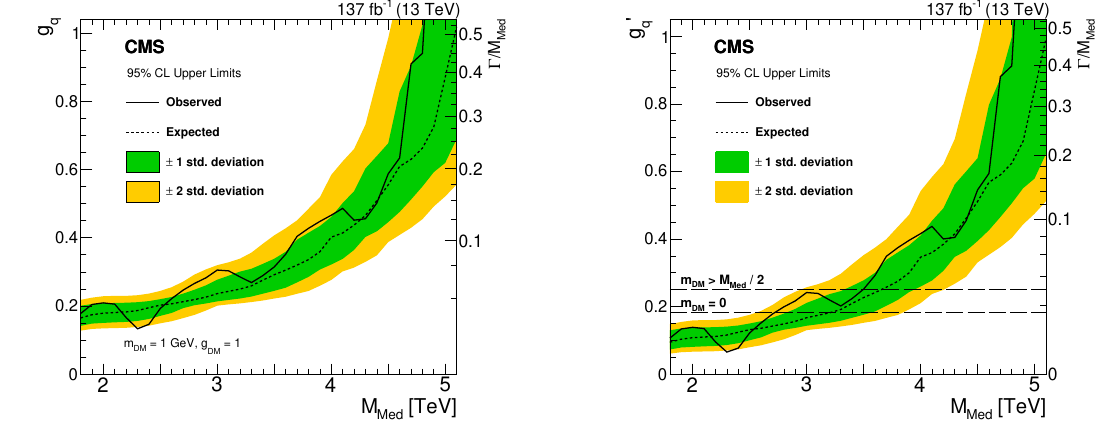
Figure 11 . The 95% CL upper limits on the universal quark coupling g as a function of resonance q mass for a vector mediator of interactions between quarks and DM particles (left), and between quarks only (right). The dashed horizontal lines on the right plot show the coupling strength for which the cross section for dijet production in this leptophobic Z 0 model is the same as for a DM mediator for g = 0 : 25. The right vertical axis shows the natural width of the mediator divided q by its mass. The expected limits (dashed lines) and their variation at the one and two standard deviation levels (shaded bands) are also